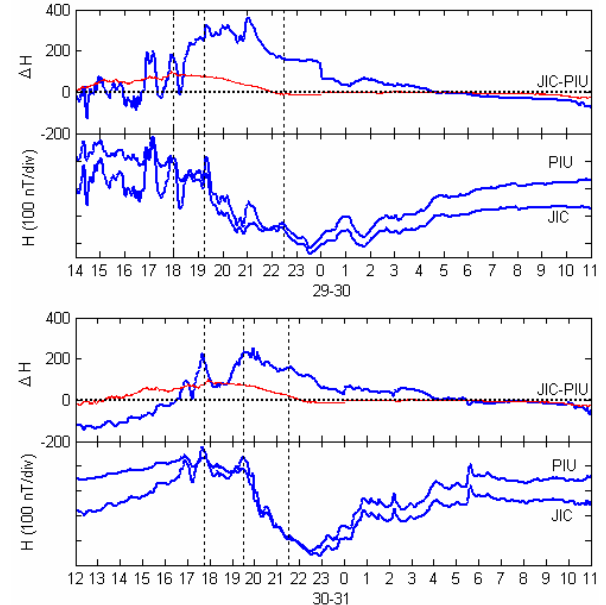
Fig. 8. H component at Jicamarca and Piura and their difference value △ H for the period 1400 UT on the 29th to 1100 UT on the 30th (top), 1200 UT on the 30th to 1100 UT on the 31st (bottom). The reference day curve is taken from 1 November. The vertical dashed lines correspond to those in Fig. 5b and c.